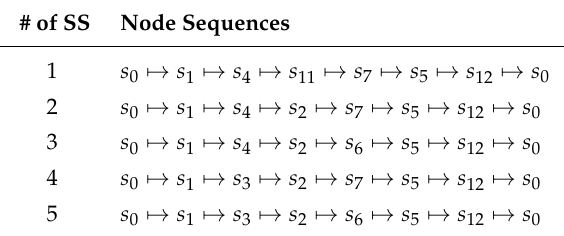
Table 5. Node sequences for initial marking vector [ p 0 p 1 p 2 p ] = [ 0 0 2 0 ] under single-server